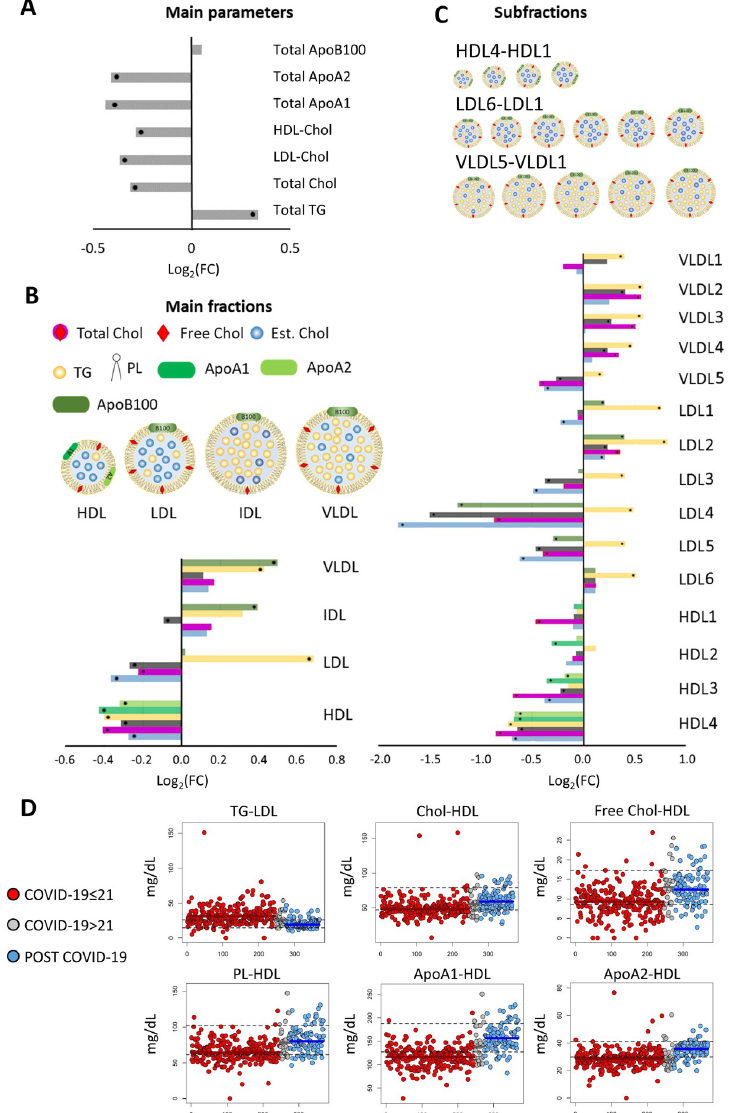
Fig 4. Lipoprotein profiling. Values of Log 2 Fold Change (FC) of lipoprotein parameters. (A) Main parameters; (B) main fractions; (C) subfractions. Positive/negative values, have higher/lower concentration in serum samples from COVID-19 � 21 patients with respect to Post COVID-19 subjects. Statistically significant parameters are marked with black dots. D) Scatter plots of concentration levels for significant main fraction parameters (p-value (FDR) � 0.05) with a “large” Cliff’s delta effect-size for the comparison COVID-19 � 21 vs. Post COVID-19 groups; red dots represent COVID-19 � 21 subjects, grey dots refer to COVID-19 > 21 subjects and blue dots to Post COVID-19 individuals; the median of each group is represented as a colored line; black dashed lines embrace the concentration ranges in a “healthy” population. subjects, have a significant p-value and a large Cliff’s delta effect size (TG-LDL, Chol-HDL, Free Chol-HDL, PL-HDL, Apo A1-HDL and Apo A2-HDL), S3 Table . As in the case of metabolites, in the COVID-19 � 21 group, the levels of these parameters are outside or on the boundary of the range of the reference “healthy” population, while in most of the Post COVID-19 samples they fall inside.